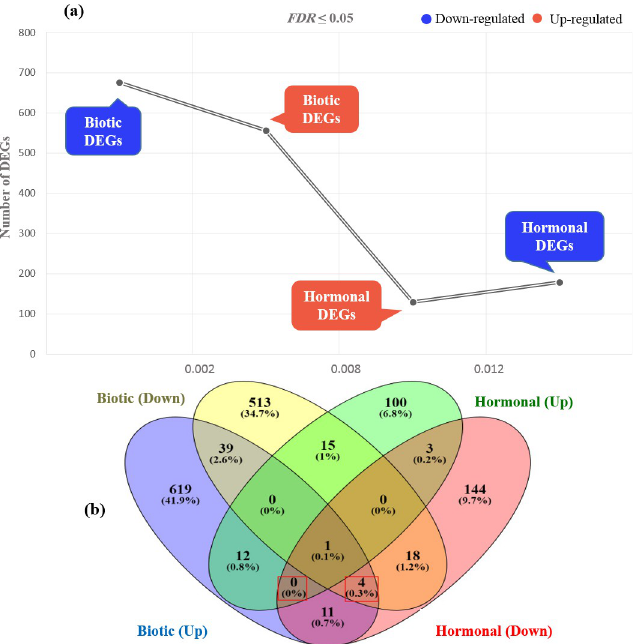
Fig 2. Venn diagrams illustrating the number of significant ( P-value � 0.05) down- and up-regulated DEGs between biotic and hormonal datasets. (a) For the biotic datasets, 556 up- and 676 down-regulated DEGs were identified. For the hormonal datasets, 179 up- and 129 down-regulated DEGs were identified. (b) 61 Common DEGs between the biotic and hormonal studies were illustrated. Four-way Venn diagrams show common and up-/down- regulated DEGs in response to biotic and hormonal stresses. In total, 12 common down-regulated DEGs and 18 common up-regulated DEGs were identified. The red rectangle highlights the total up- and down-regulated DEGs ( P- value � 0.05). In fact, the completely biotic DEGs are common to the up-regulated hormonal DEGs in the four DEGs, but there is no commonality between the whole hormonal DEGs and the down-regulated biotic